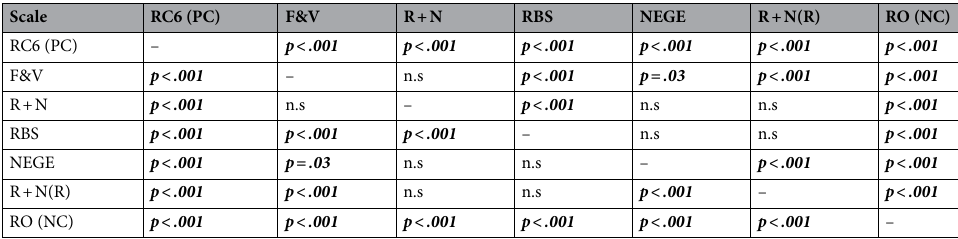
Table 2. Tukey post-hoc test results for the accuracy. [RC6 (PC): Restructured Clinical 6 (Positive Control); F&V: Fenigstein & Vanable; R + N: RBS + NEGE (Combined); RO (NC): Random Observation (Negative Control)]. Significant values are in